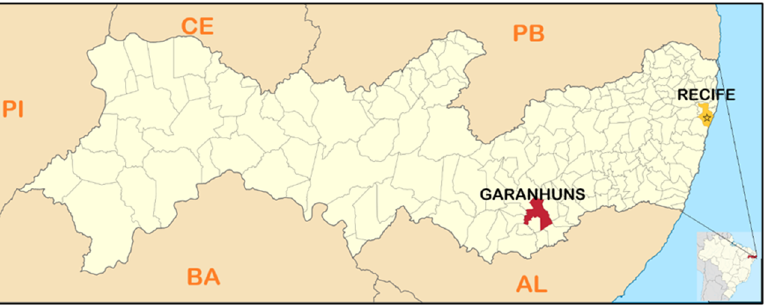
Figure 2. Map of Pernambuco with the city of Garanhuns and the capital Recife marked (Adapted from Google Maps).